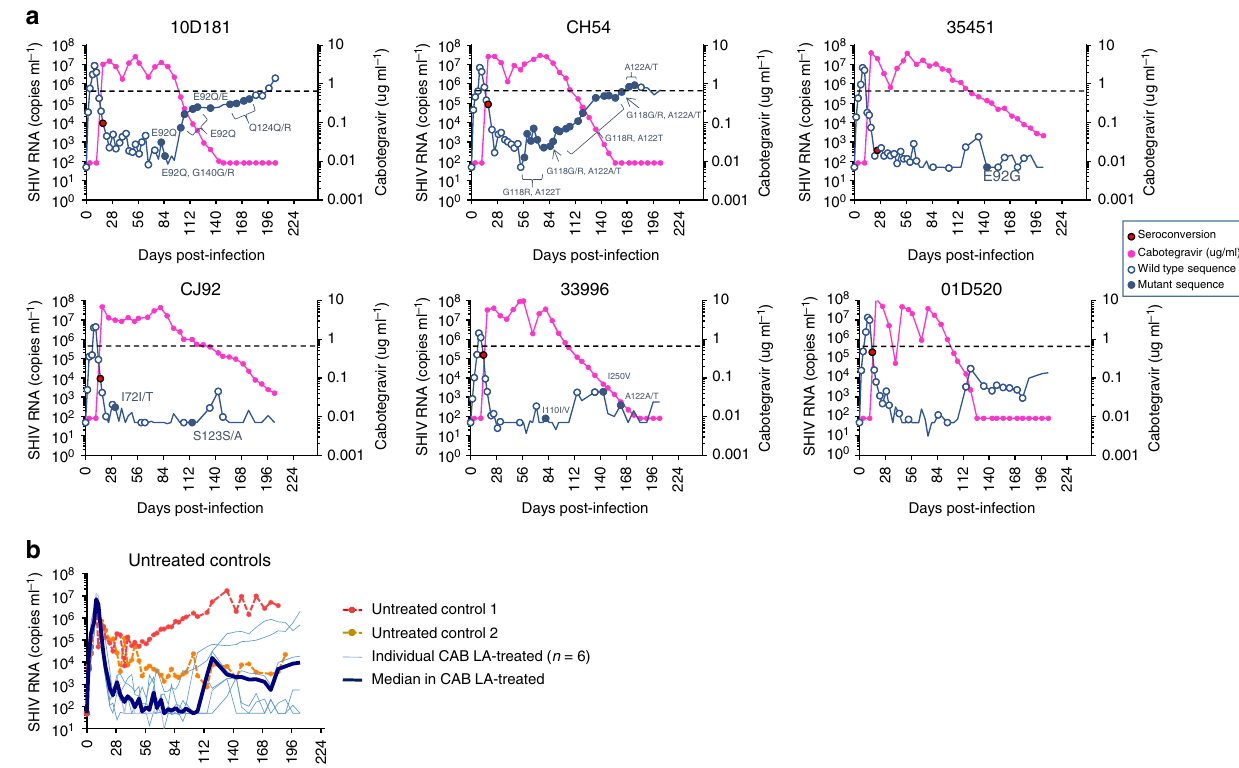
Fig. 1 Acute SHIV infection dynamics and concentrations of cabotegravir in plasma. a Plasma SHIV RNA levels (blue line) and cabotegravir concentrations (magenta line) in the six macaques treated with cabotegravir long-acting (CAB LA). CAB LA injections were given at days 11, 39, and 67. Macaques seroconverted at days 14 – 25, always after the fi rst CAB LA injection at day 11. The 4xPA-IC 90 value (0.664 μ g/ml) is shown with a horizontal dotted line. Red circles denote the day of seroconversion. Open blue circles are wild type (WT) integrase sequences and close blue circles are time points with integrase mutations. Time 0 denotes the day of intravenous SHIV inoculation. b Plasma SHIV RNA levels in two untreated controls are compared with the median levels observed in the six CAB LA-treated animals. Individual CAB-LA-treated animals are also shown in light blue. Source data are provided as a